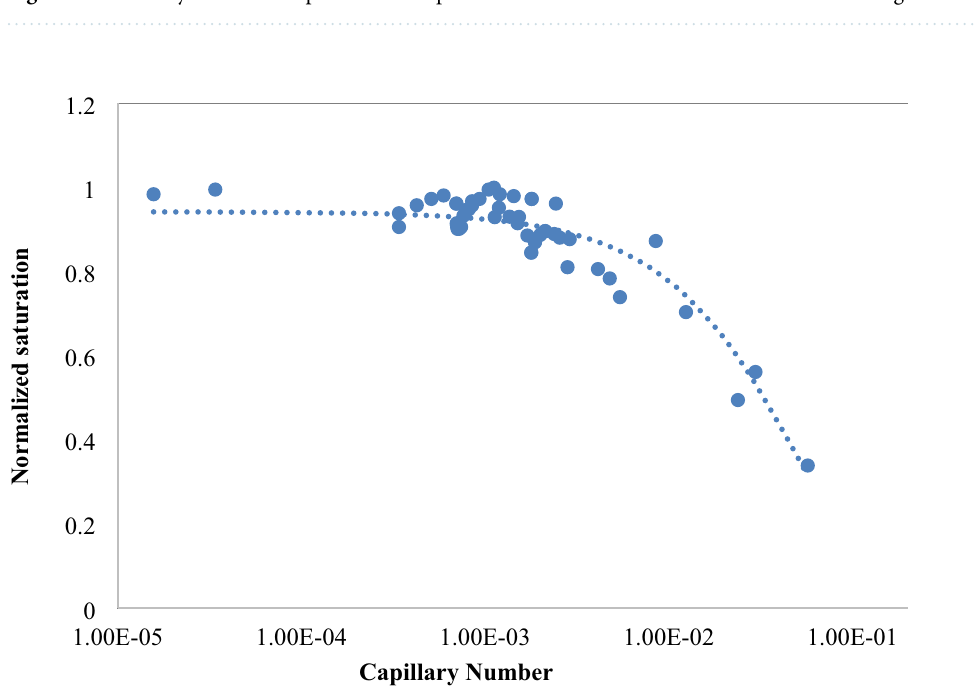
Figure 4. Accuracy of the developed model for predicted and actual values of RF% in water flooding.